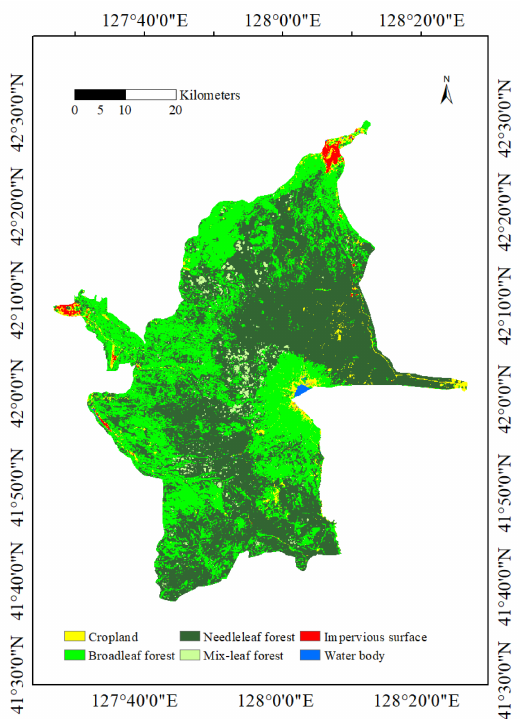
Figure A1. Land cover prediction of Changbai Mountain Reserve in